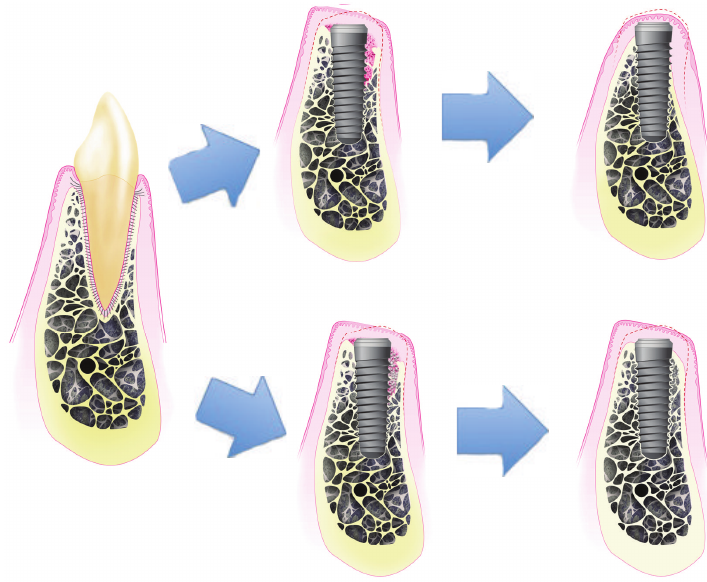
Figure 2: Healing of the extraction socket, with postextractive implant placement, with and without socket grafting. After tooth extraction and immediate implant placement, the blood clot fills the remaining space and the bundle bone undergoes the physiological changes. When grafting material is placed around the implant surface, filling the remaining socket area, the buccal bone wall remodeling process is corrupted, thus leading the maintenance of the horizontal ridge